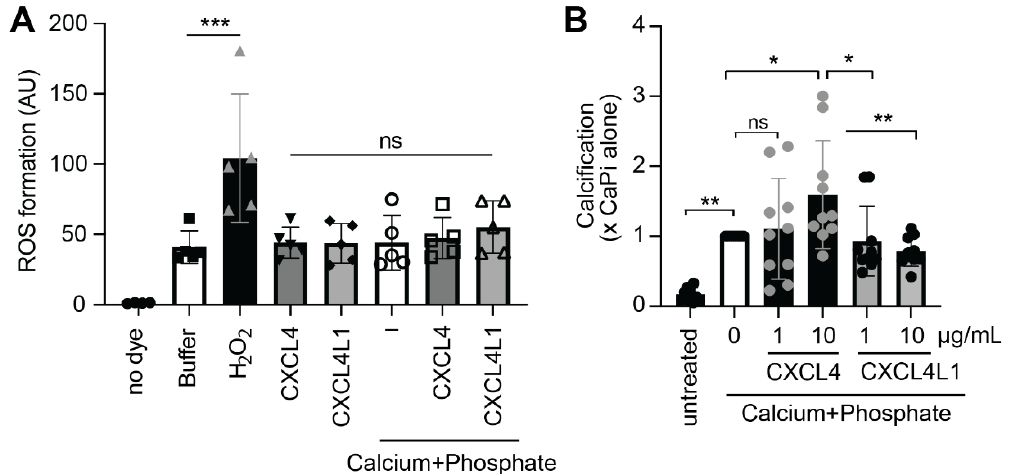
Figure 6. Formation of reactive oxygen species (ROS) and calcium mineral crystals in VSMCs. ( A ) Cultured VSMCs in DMEM/2.5% FCS overnight, loaded with or without DCFDA dye and stimu ‐ lated with vehicle, CXCL4 or CXCL4L1 (10 g/mL) in the presence or absence of calcium (2.7 mM) and phosphate (2.5 mM). ROS formation was expressed as arbitrary fluorescence units (AU). Non ‐ significant: ns, *** p < 0.001, n = 4, one ‐ way ANOVA with Sidak post test. ( B ) Cultured VSMCs in DMEM/20% FCS treated with or without calcium (2.7 mM) and phosphate (2.5 mM) in the presence of vehicle, CXCL4 or CXCL4L1 (1 and 10 g/mL). Calcification was expressed as fold control in the absence of chemokines (white bar). * p < 0.05, ** p < 0.01, *** p < 0.001, n = 10 independent experi ‐ ments, one ‐ way ANOVA with Sidak post test.